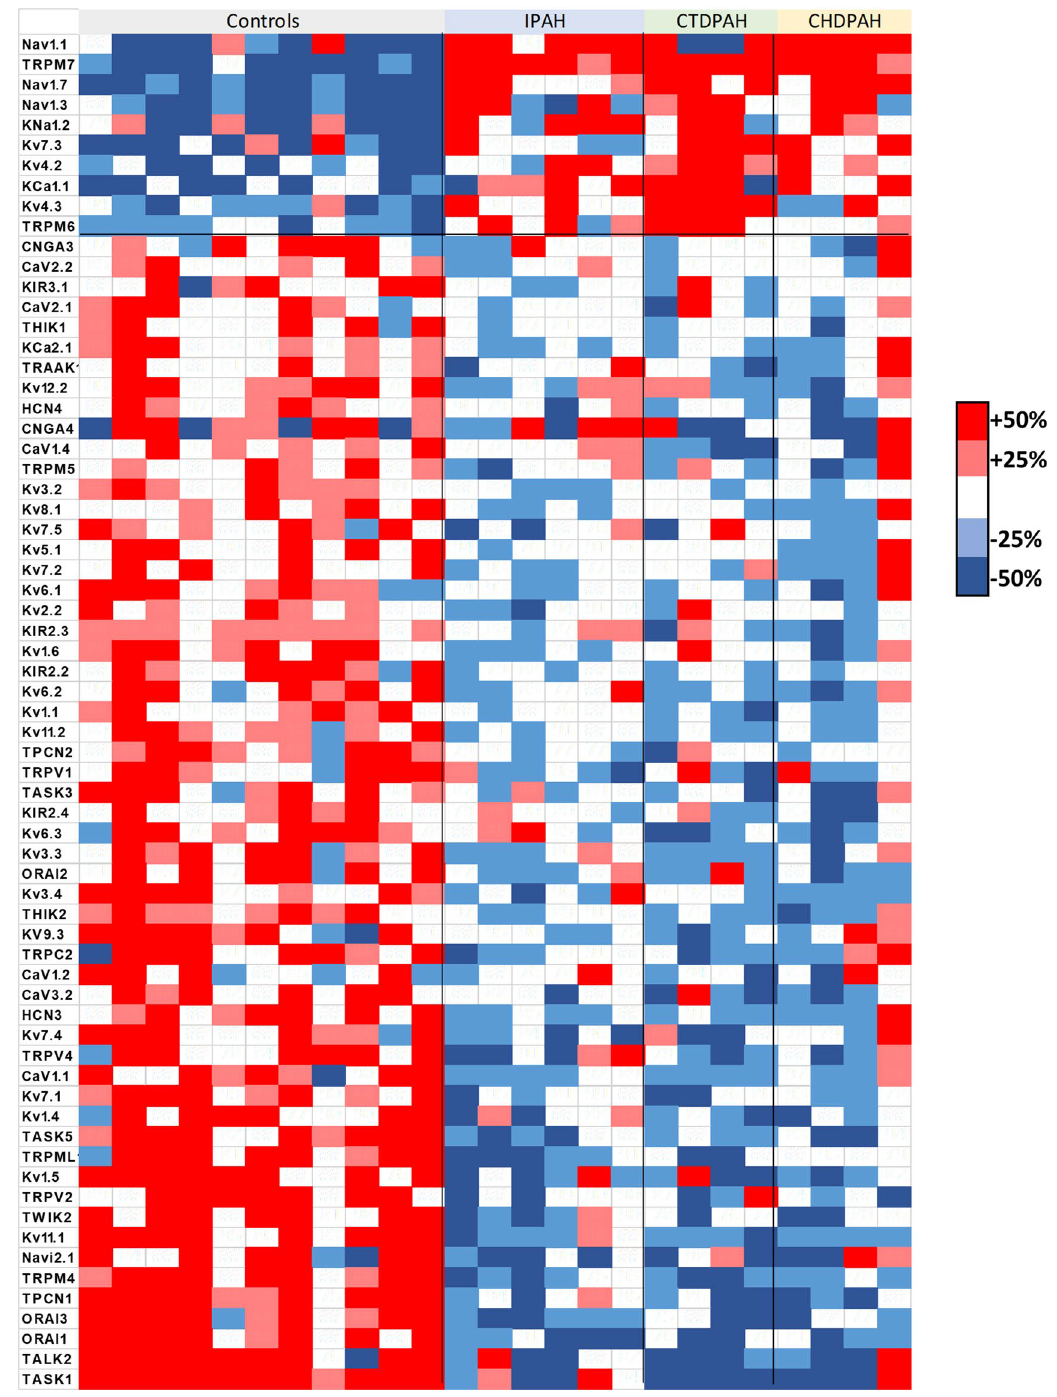
Figure 3. Heat map of genes encoding cationic channel that displayed significant difference (adjusted p < 0.05) in